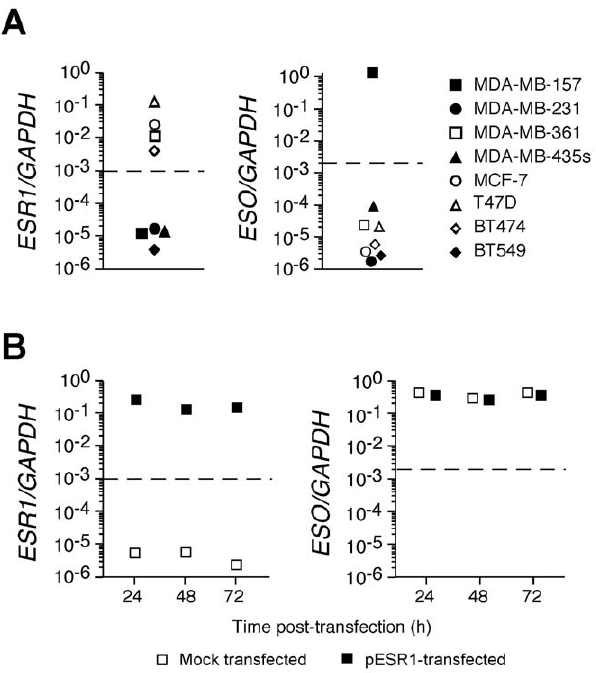
Figure 5. Expression of ESO in triple negative BC. Expression was assessed by IHC staining of paraffin-embedded tumors using the ESO- specific mAb E978. Tumors were scored based on the percentage of positive cells (-, 0-rare; 1, , 10%; 2, 10–25%; 3, 25–50%; 4, . 50%) and the staining intensity (A, faint; B, moderate; C, strong). Testis (positive control, a ), normal breast (negative control, b ) and examples of triple negative tumors scored as negative ( c ), 4B ( d ), 3C (e ) and 4C ( f ) are shown. Magnification: 6 20.